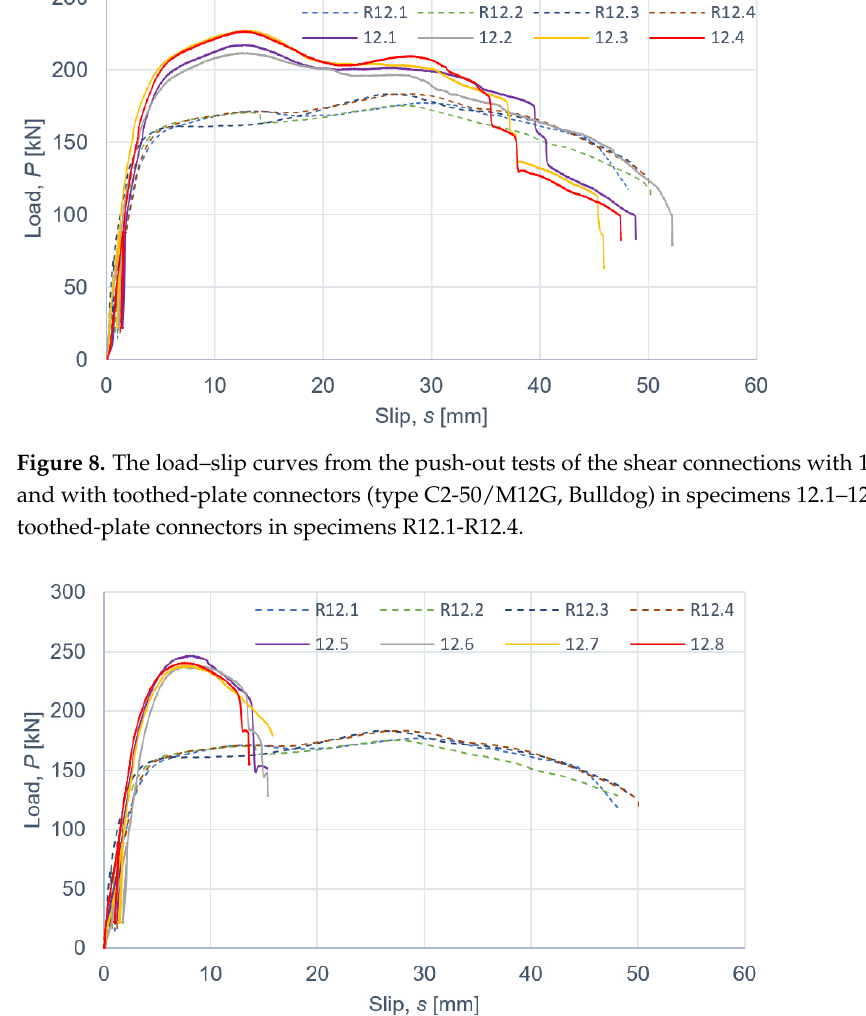
Figure 9. The load–slip curves from the push-out tests of the shear connections with 12 mm screws and with toothed-plate connectors (type C11-50/M12, Geka) in specimens 12.5–12.8 or without toothed-plate connectors in specimens R12.1-R12.4.